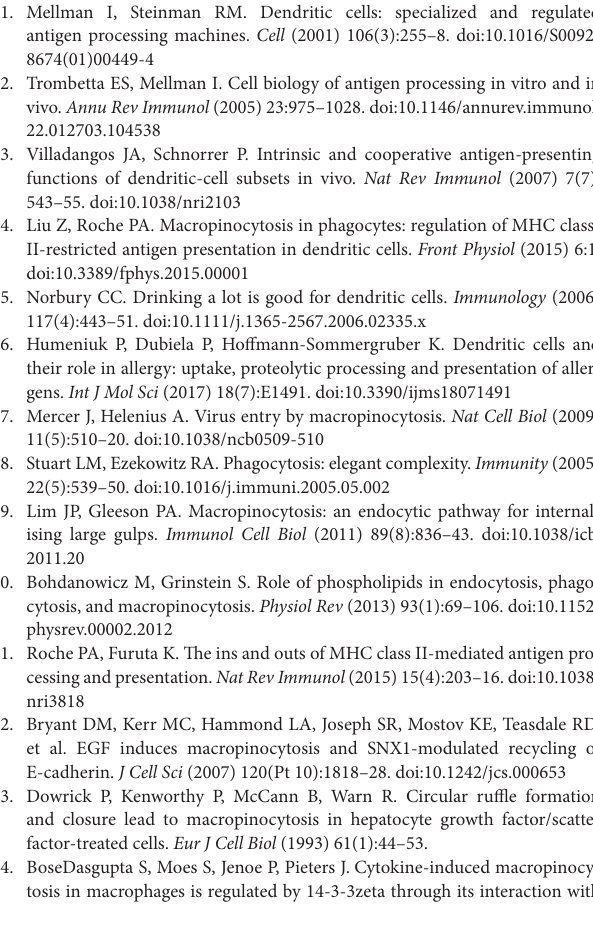
FigUre s8 | Loss of Nox2 in BMiDCS attenuates PMA-stimulated macropinocytosis of ovalbumin (OVA). Nox2 y/ + and Nox2 y/ − BMiDCs were incubated with vehicle or stimulated with PMA (1 µM, 5 h) in the presence of FITC-OVA. FITC fluorescence was analyzed in CD11c + cells using fluorescence-activated cell sorting (FACS) ( n = 3). *p < 0.05 vs. vehicle, # p < 0.05 vs. Nox2 y/ + PMA. FigUre s9 | “PMA + OVA” treatment induces a more pronounced secretion of DC-derived T-cell regulatory cytokines compared to PMA treatment alone. (a–B) WT BMiDCs left untreated or treated with PMA or PMA + OVA for 24 h. Cell culture supernatants were collected and levels of secreted cytokines determined using the LEGENDplex ™ bead-based immunoassay. * p < 0.05 vs. vehicle, and @ p < 0.05 vs. PMA. (c–D) WT, PKC δ − / − , and Nox2 y/ − BMiDCs were left untreated or treated with PMA for 24 h. Cell culture supernatants used for cytokine estimation as described in (a–B) . Data are representative of three independent experiments and values are expressed as mean ± SD. * p < 0.05 vs. vehicle and @ p < 0.05 vs. WT PMA.